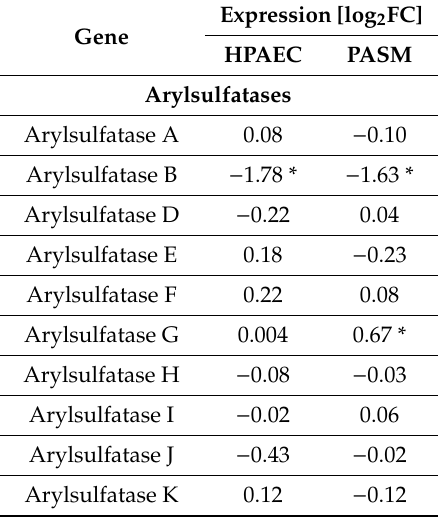
Table 2. Expressions of arylsulfatases transcripts in HPAEC and PASM cells with decreased expression of the ARSB gene. In PASM cells, reduction of ARSB expression is accompanied by upregulation of arylsulfatase G ( ARSG ), but this e ff ect is not observed in HPAEC cells. Data from microarrays experiments are shown as the change between expression in cells transfected with siARSB and non-targeting siRNA. Genes with significantly di ff erent expression are marked with an asterisk. Expression [log 2 FC] Gene HPAEC PASM Arylsulfatases Arylsulfatase A